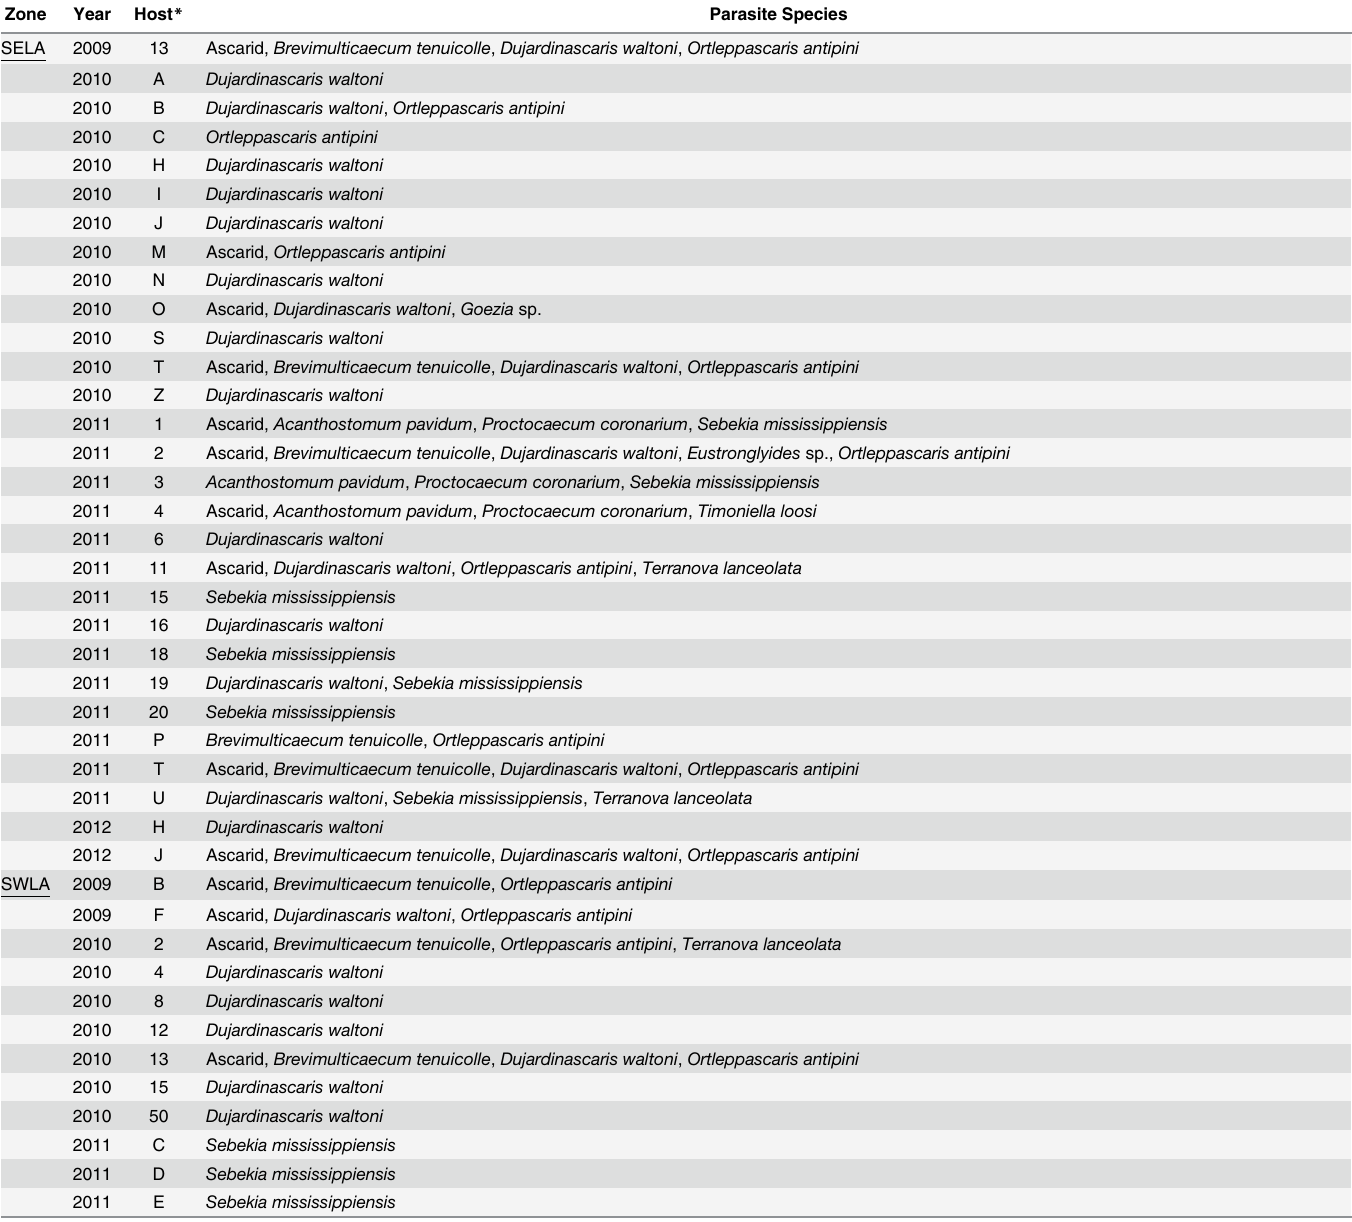
Table 1. Summary of parasite species collected from each alligator host/year in each geographic zone. Zone Parasite